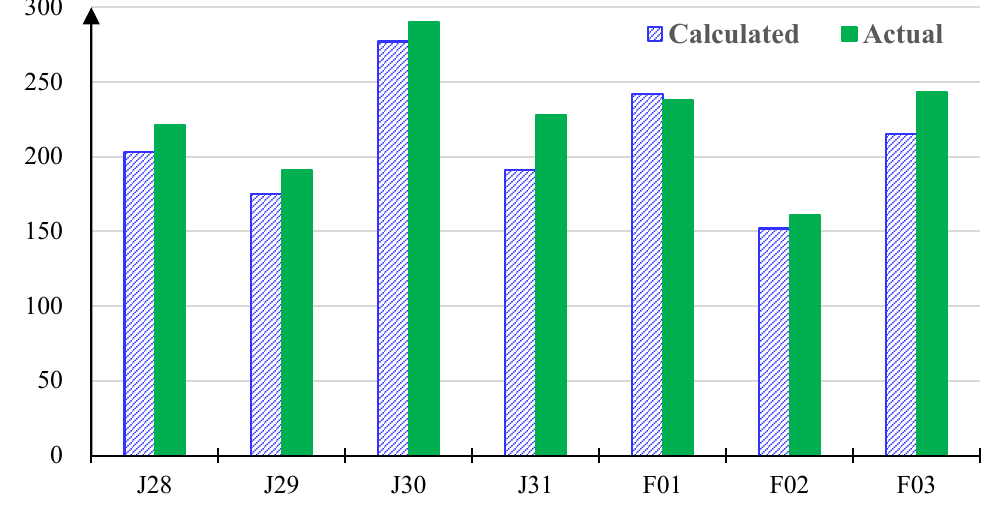
Figure 4. Comparison of the calculated and actual average exposure times on the test instances. The horizontal axis denotes the test instance, and the vertical axis denotes the average exposure time (in